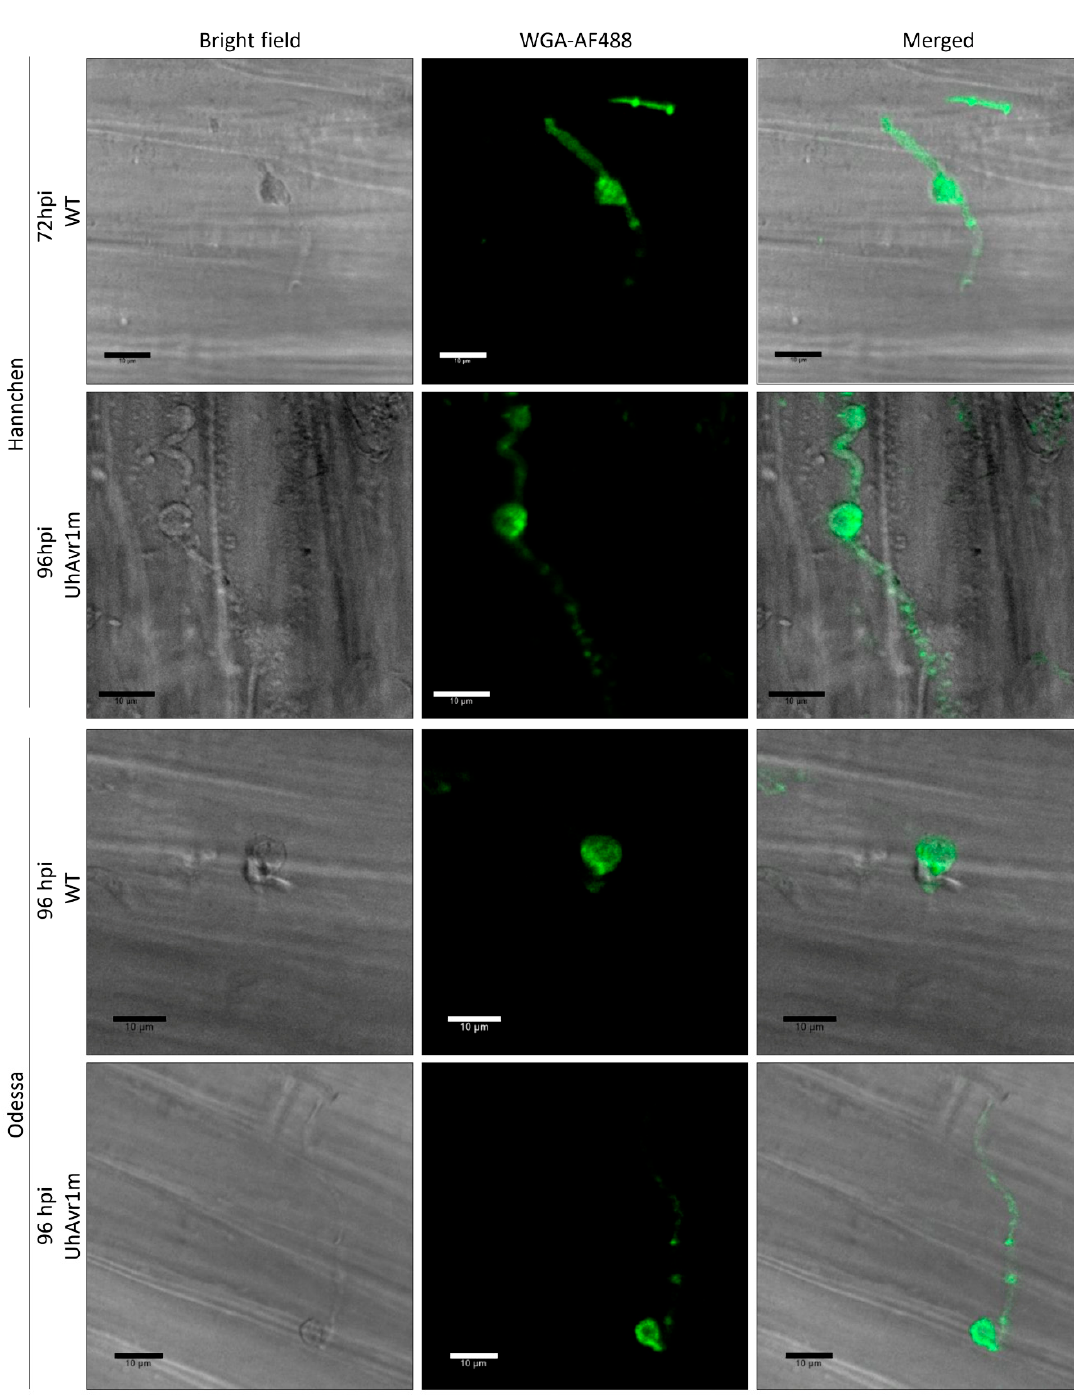
Figure 2. Appressorium-like structures are seen in both types of interaction. Seedlings from the cv. Odessa and cv. Hannchen were infected with WT or UhAvr1m teliospores followed by staining with WGA-AF488 (green). A putative appressorium with a knob-like structure was seen during imaging of coleoptiles 48 hpi. Thin septated hyphae emanating from the appressorium-like structure are noticeable in confocal microscopy that di ff er from the non-septated hyphae found anterior to it. Scale bar represents 10 µ m. All images are a snapshot of a single z-stack.